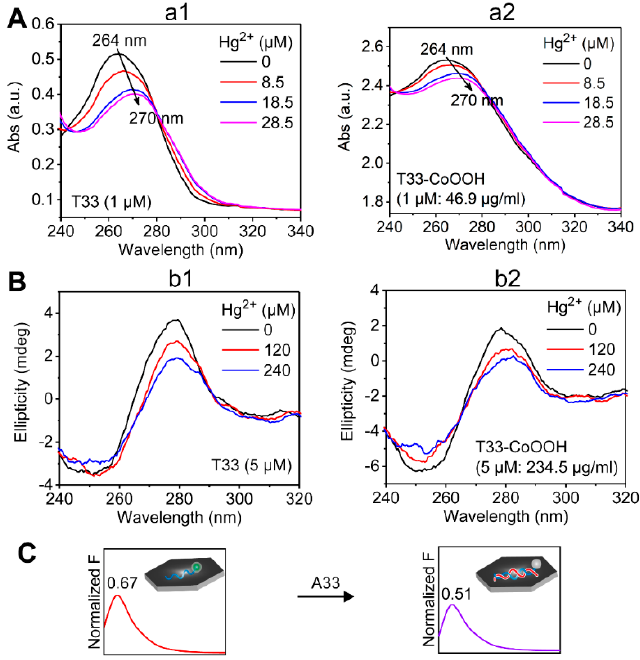
Figure 3. ( A ) Absorption response of T33 (a1, 1 μ M) and T33–CoOOH (a2, 1 μ M:46.9 μ g/mL) on addition of Hg 2+ ions; ( B ) CD spectra of T33 (b1, 5 μ M) and T33–CoOOH (b2, 5 μ M:234.5 μ g/mL) on addition of Hg 2+ ions. Buffer: 5 mM Tris-HCl, pH 7.4; ( C ) Fluorescence responses of the T33–CoOOH complex to T33’s fully complementary DNA A33. T33: 100 nM, CoOOH nanosheets: 4.69 μ g/mL, A33: 300 nM.